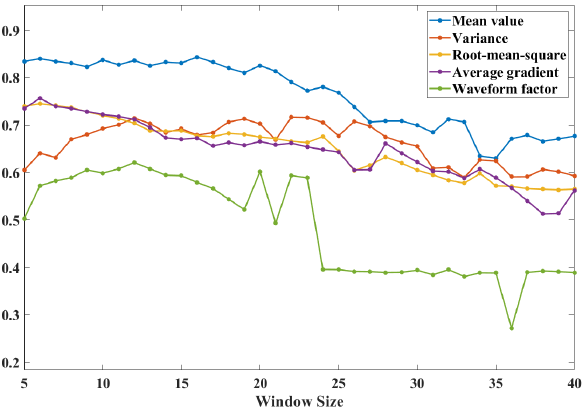
Figure 9. Change of eigenvalue recognition rate with sliding window size.